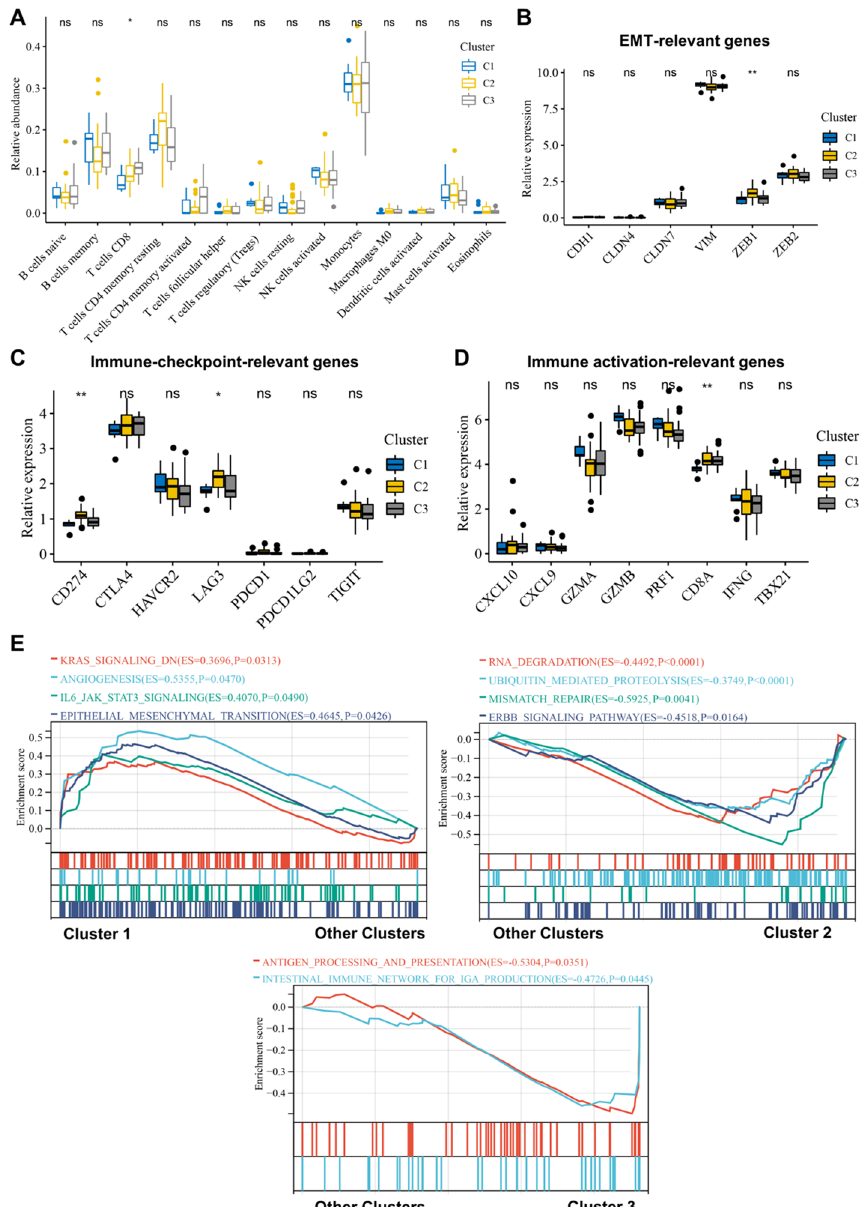
Fig. 4 Immune-related features of response-related clusters. a The relative abundance of each circulating immune cells in three response-related clusters. The upper and lower ends of the boxes represented interquartile range of values. The lines in the boxes represented median value, and dots showed outliers. b EMT-relevant genes (CLDN7, CLDN4, CDH1, VIM, ZEB1, and ZEB2) expressed in three response-related clusters. c Immune-checkpoint-relevant genes (CD274, CTLA4, HAVCR2, LAG3, PDCD1, PDCD1LG2, and TIGIT) expressed in three response-related clusters. d Immune activation-relevant genes (CD8A, CXCL10, CXCL9, GZMA, GZMB, IFNG, and TBX21) expressed in three response-related clusters. Within each cluster, the upper and lower ends of the boxes represented interquartile range of values. The lines in the boxes represented median value, and black dots showed outliers. e Enrichment plots showing the relatively significantly enriched pathways in clusters 1, 2 and 3. Different pathways are indicated by different colors in each enrichment